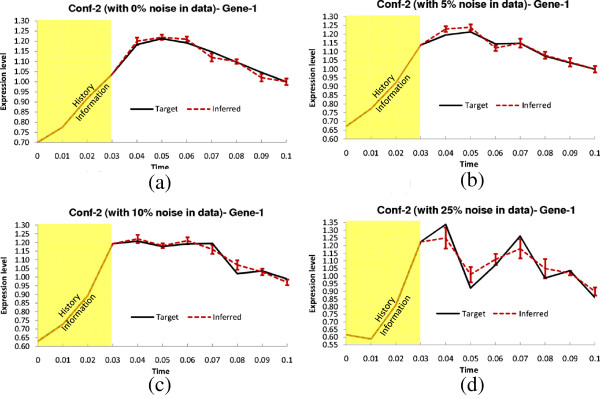
Dynamics for Gene-1 of Conf-2. Solid lines and dotted lines indicate respectively target and inferred (by TDSS) time-expressions in (a) Noise free data (b) 5% Noise in data (c) 10% Noise in data (d)25% Noise in data. The yellow shaded region indicates the history information and the error bars indicate 95% confidence interval.